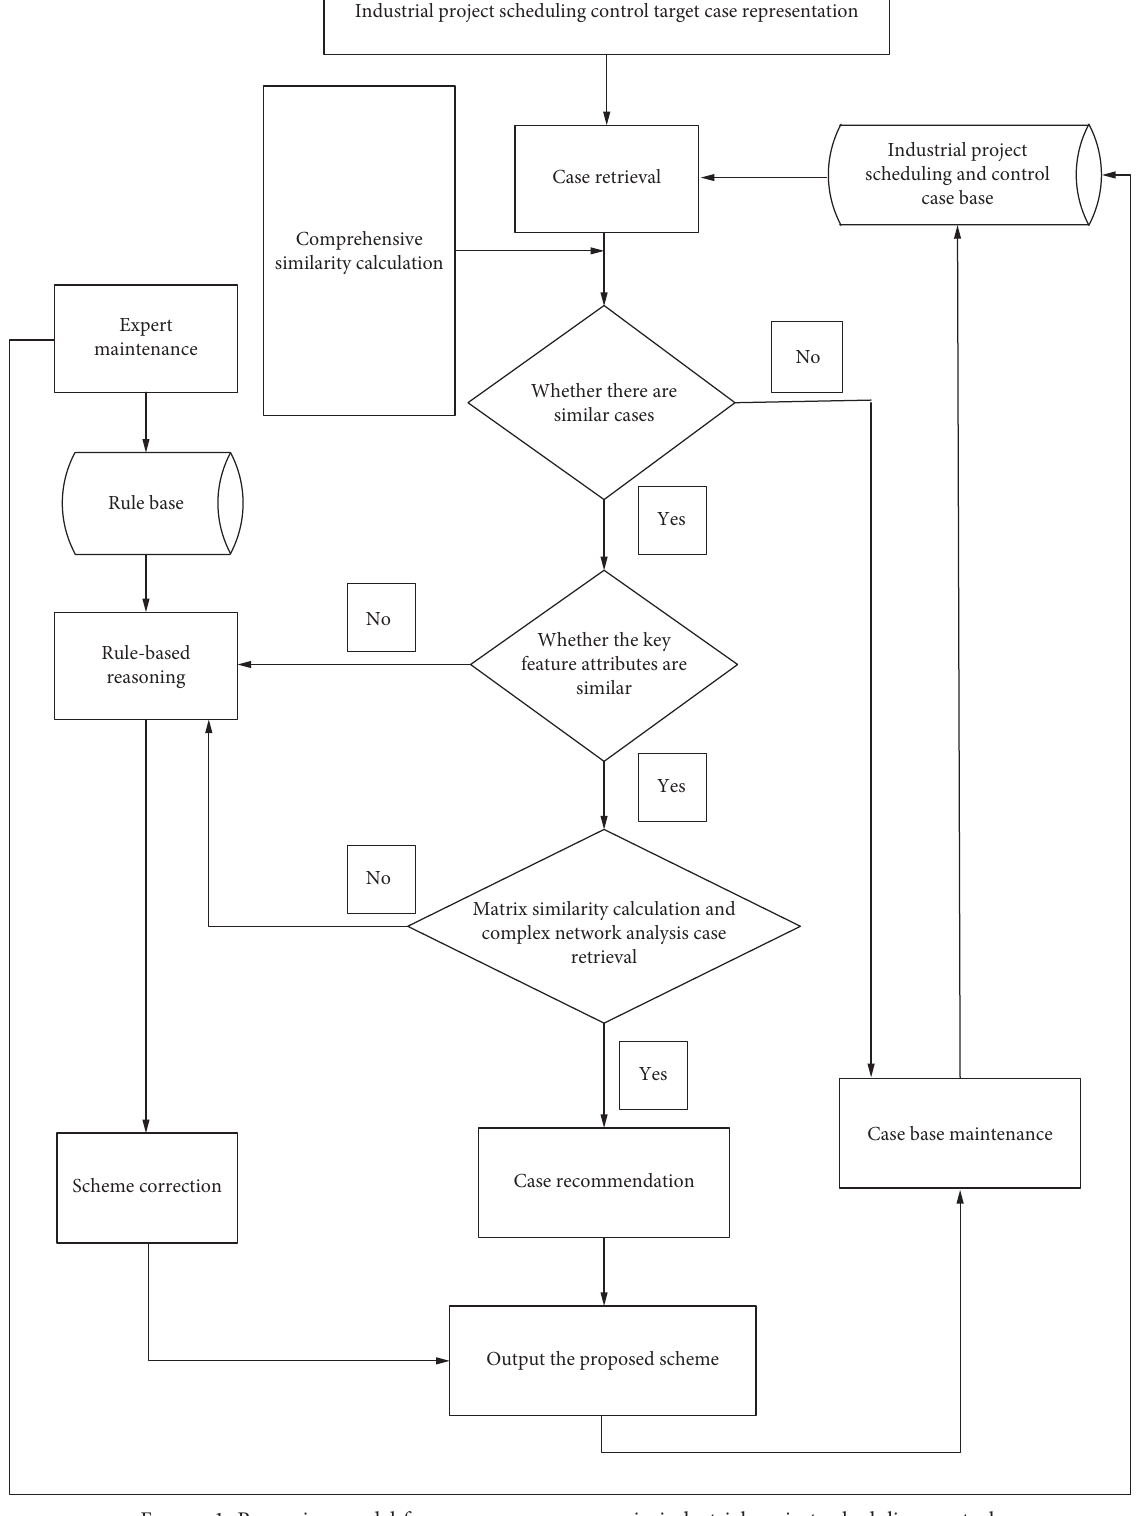
Figure 1: Reasoning model for emergency measures in industrial project scheduling